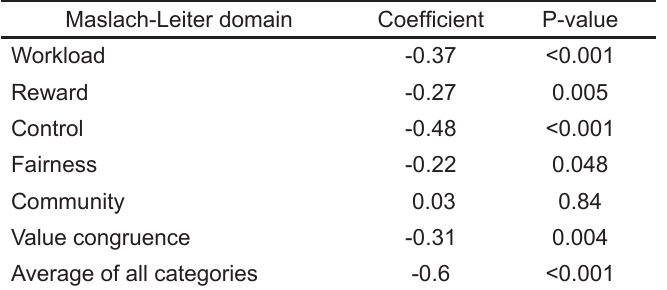
Table 3. Association of Maslach-Leiter categories with burnout scores, using univariate regression. Negative coefficients reflect that higher (better) scores in a given domain were associated with lower burnout (N =